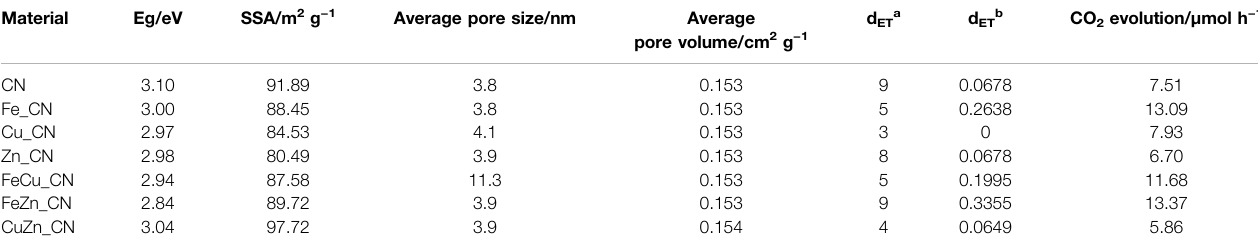
TABLE 2 | Physical properties and photocatalytic activities of CN and metal-doped CN. In this work, two groups of materials were classi fi ed based on their high (green) and low CO 2 evolution (black). Material